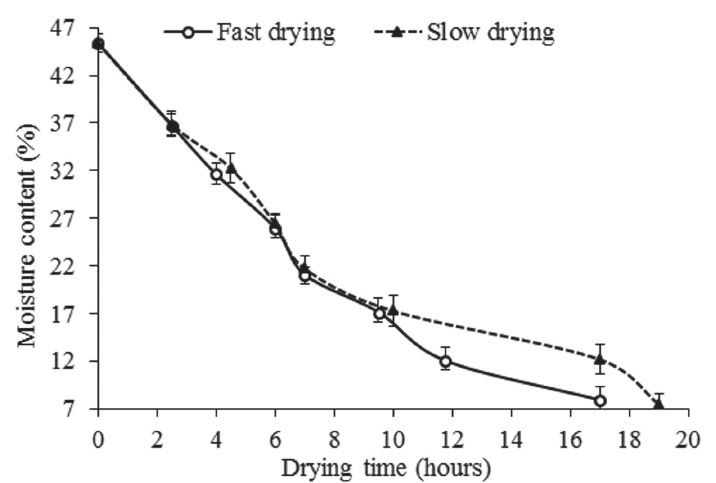
Figure 1 - Drying rate of Campomanesia adamantium seeds: fast drying (silica gel) and slow drying (room